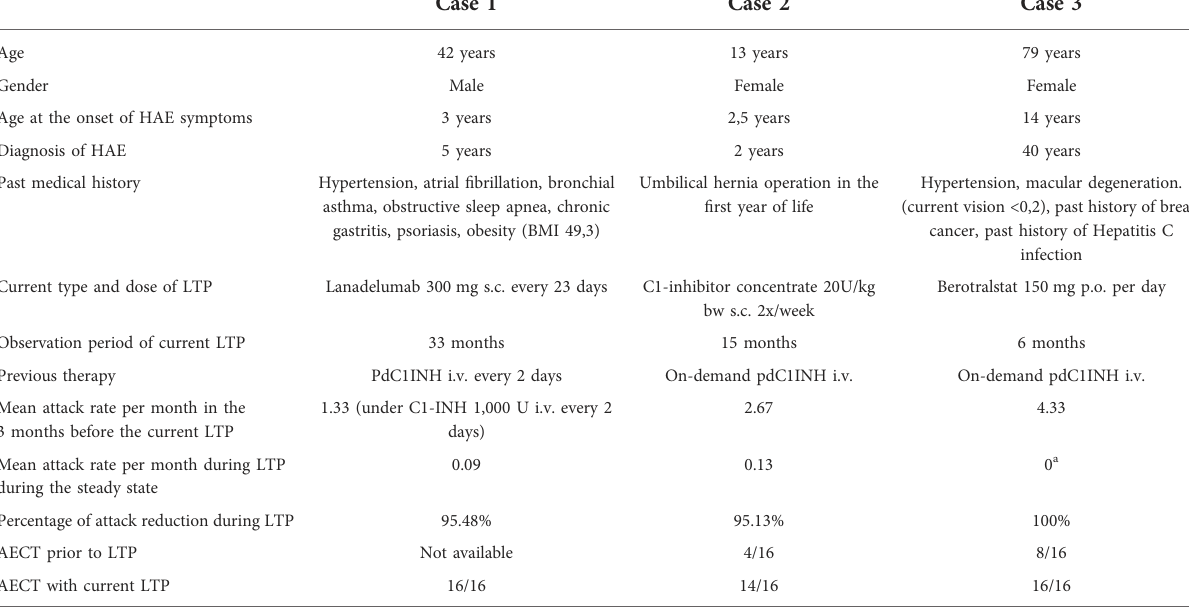
TABLE 1 Demographics, clinical characteristics, and treatment